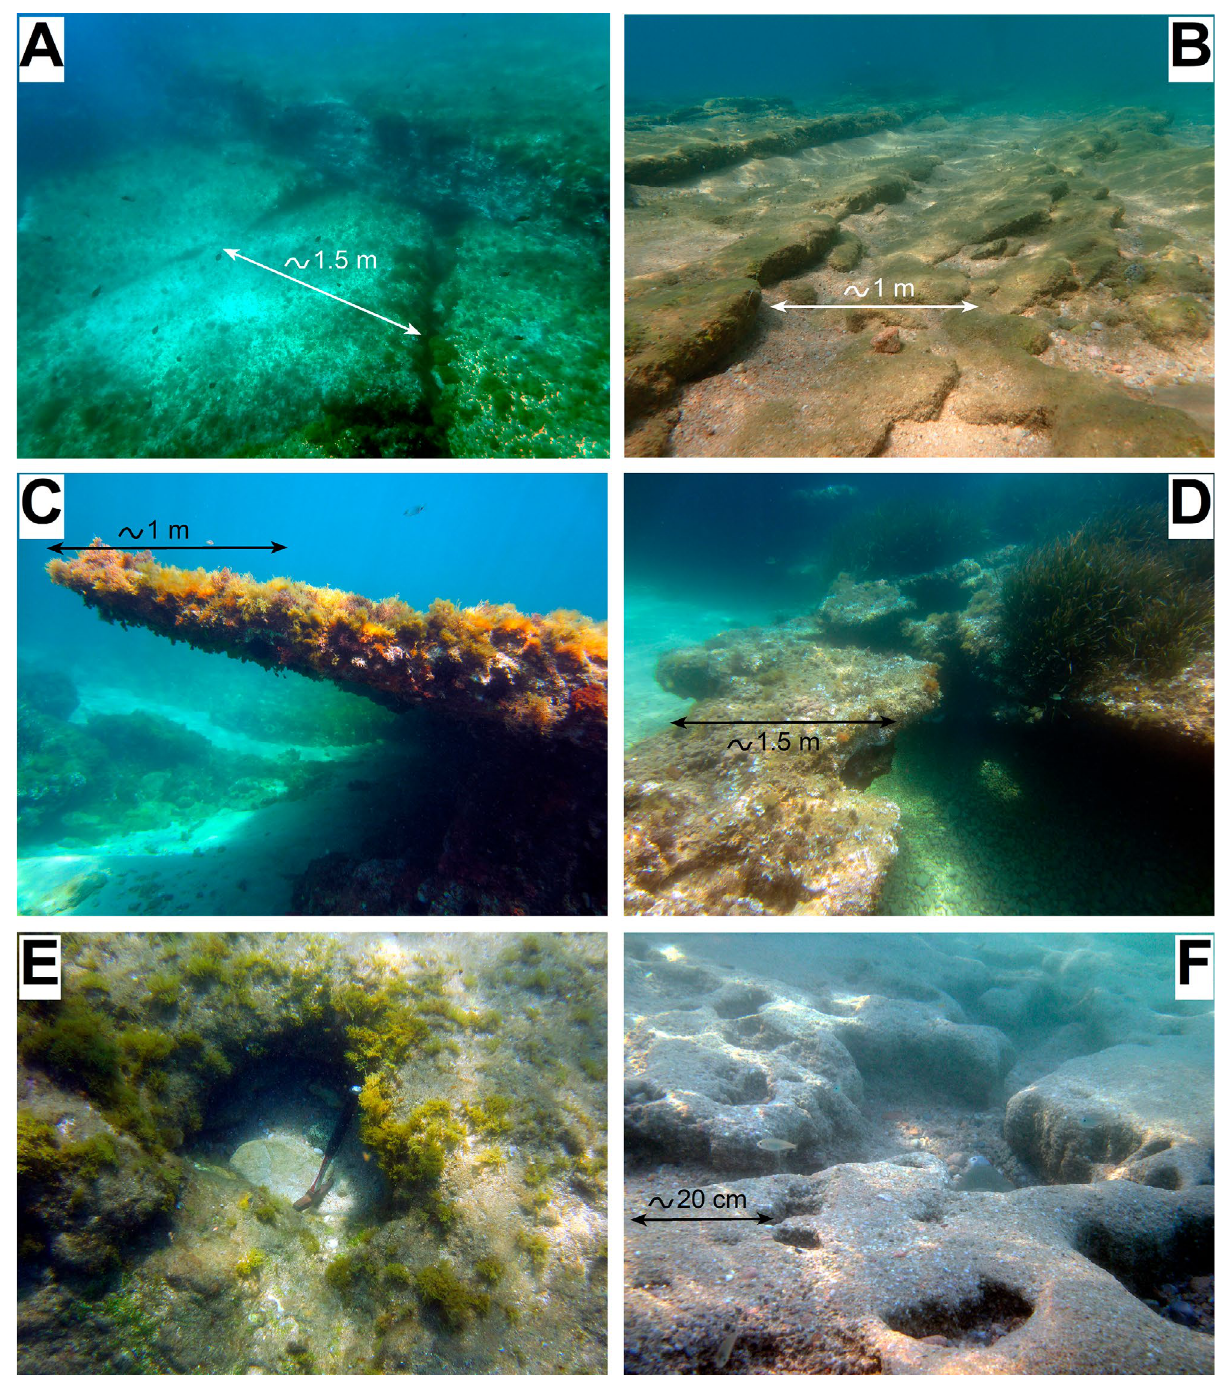
Fig. 8. – Erosion features. A, orthogonal joints delimiting partially collapsed blocks in the distal part of the CA17 beachrock. B, cuesta shape (CA14). C, visor (CA6). D, short tunnel partially collapsed (CA15). E, erosional potholes (CA9, hammer for scale). F, complex shapes caused by the growth and interference of erosional potholes